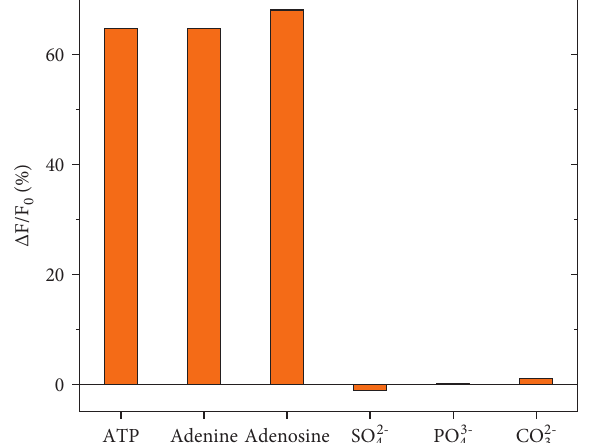
Figure 3: Influence of the presence of anion or neutral molecules (10 − 4 M) on the luminescence of 1 (24 mg/L; Tris-HCl buffer solution (pH 7.4)).